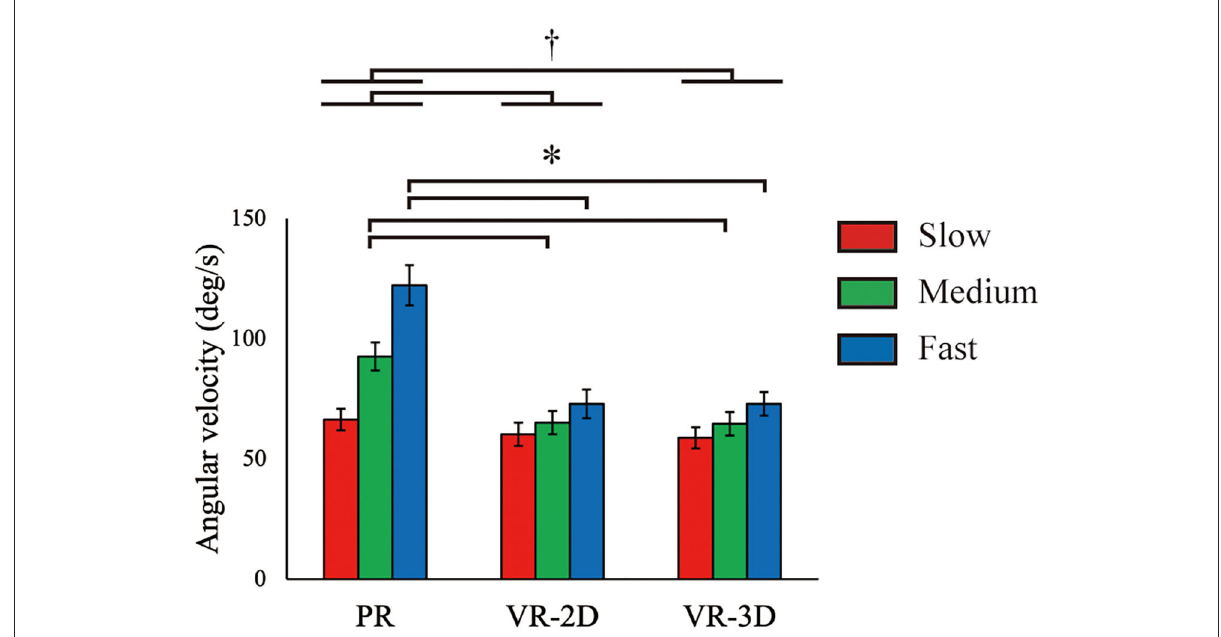
FIGURE7 Mean (error bar: SE) of the shoulder flexion velocity ( ω flexion ). The asterisk (*) indicates the significant pairwise differences ( p < 0.05) after a significant interaction between environment and ball speed was found. The dagger (†) indicates the significant pairwise differences ( p < 0.05) after a significant main effect of environment was found.